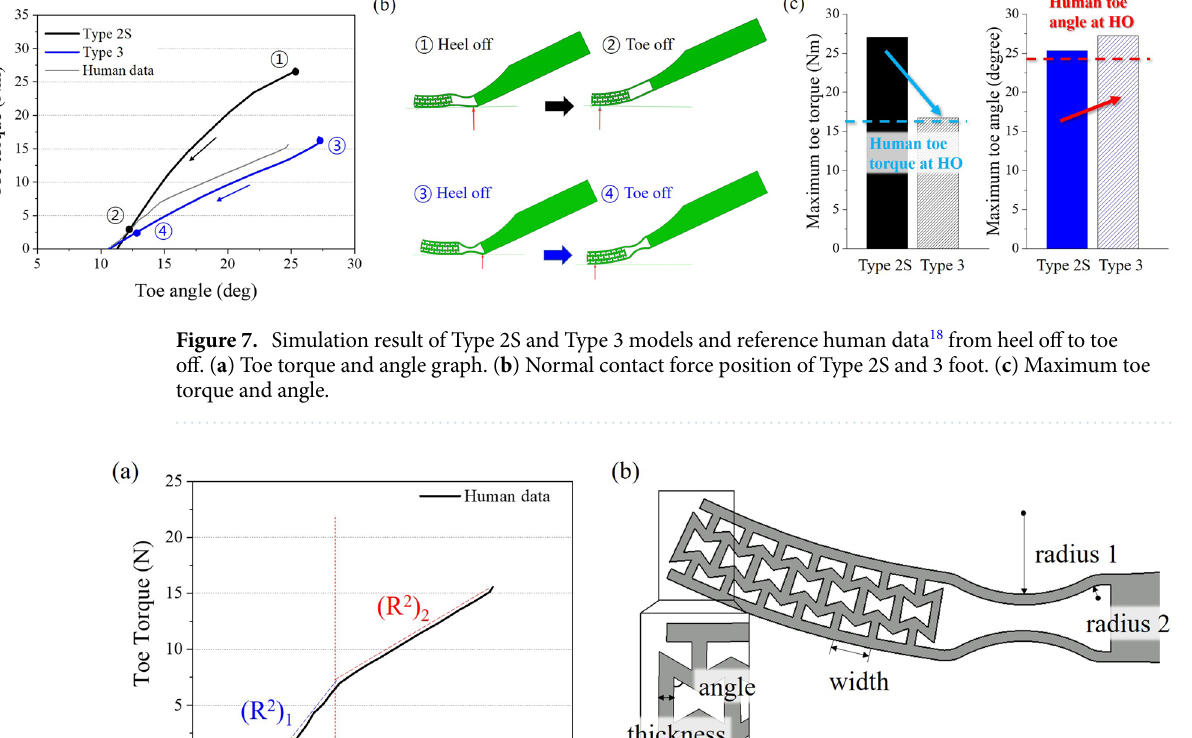
Figure 8. ( a ) Calculation area of coefficients of determination ( ( R design variables of the Type